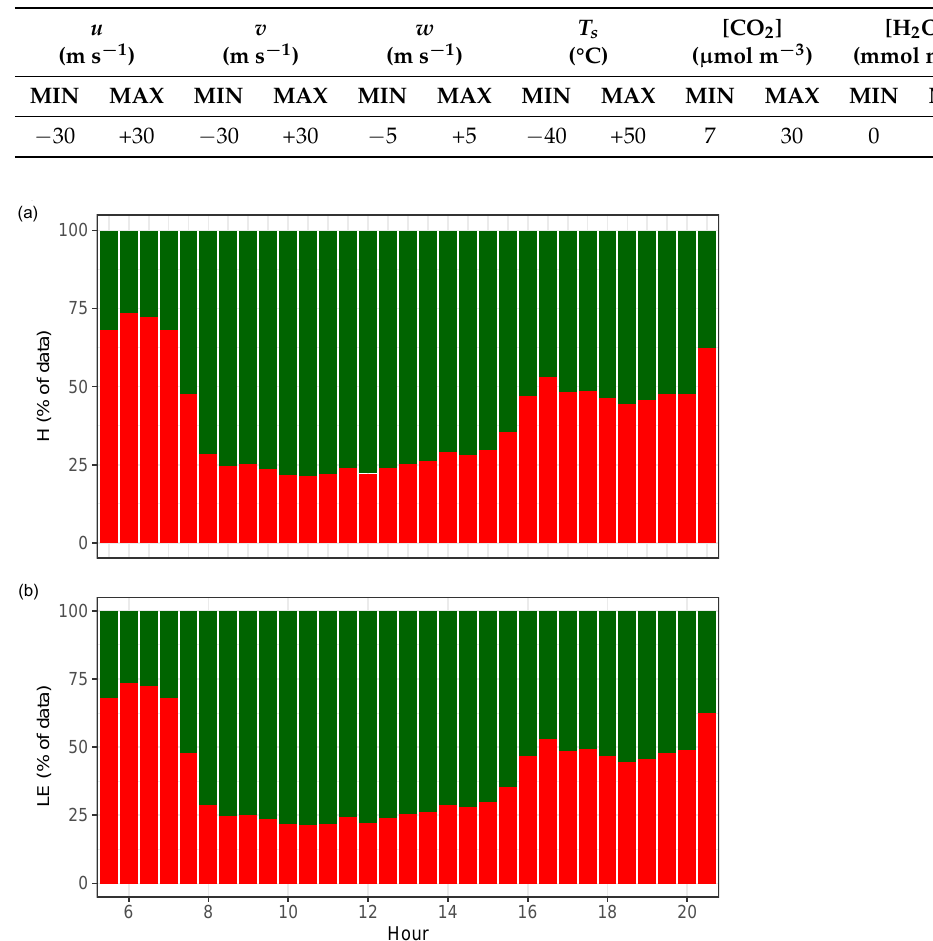
Table A2. Extremes of physical plausible data for the Cogne site for wind speed anemometric components ( u , v , w ), sonic temperature ( T s ), CO 2 and H 2 O concentration values.